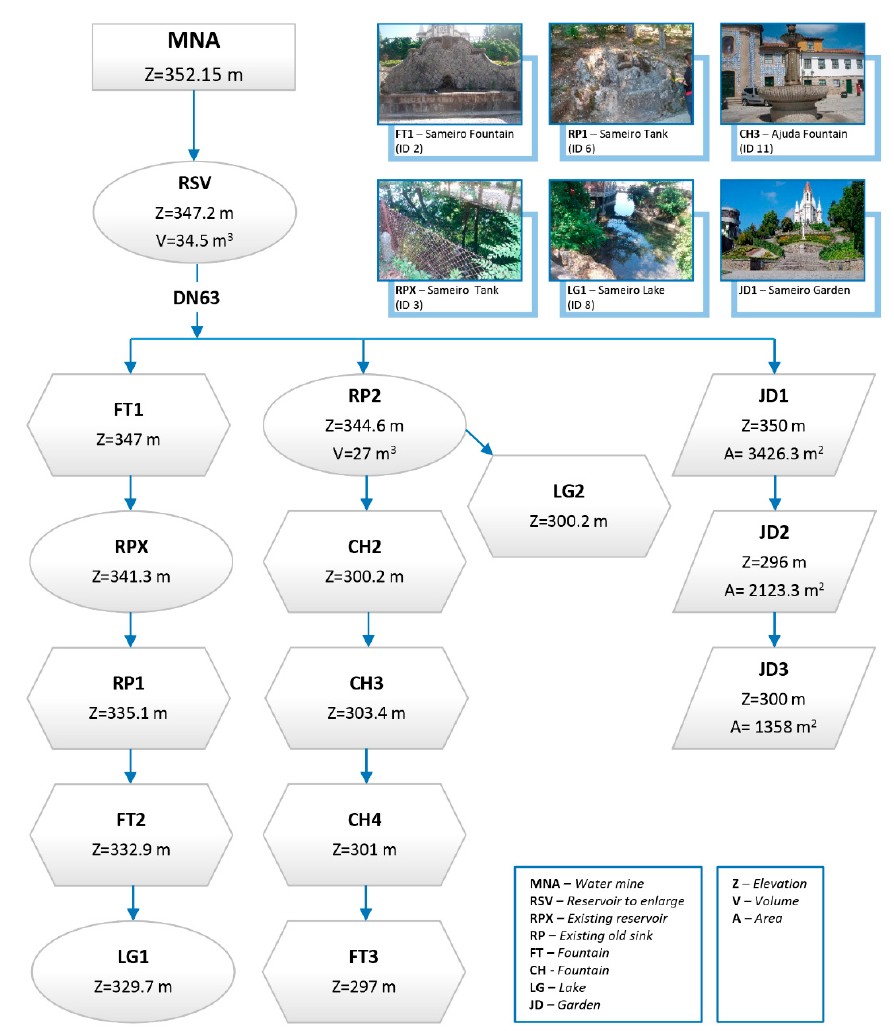
Figure 4. The design scheme of the proposal for the supply network of fountains and irrigation of green spaces.